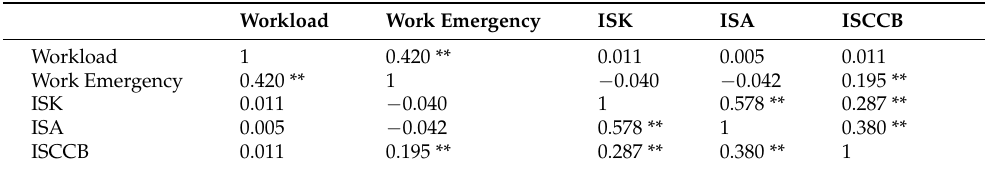
Table 6. Correlations among work load, work emergency, security risk of knowledge, attitude, and behavior.